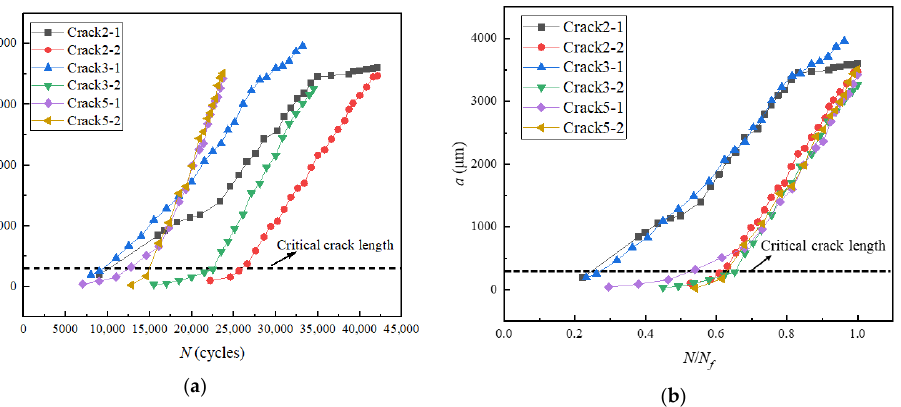
Figure 14. Variation of crack length of cruciform specimen with circular notch in the central area. ( a ) Variation of crack length with cycle number. ( b ) Variation of crack length with cycle ratio.